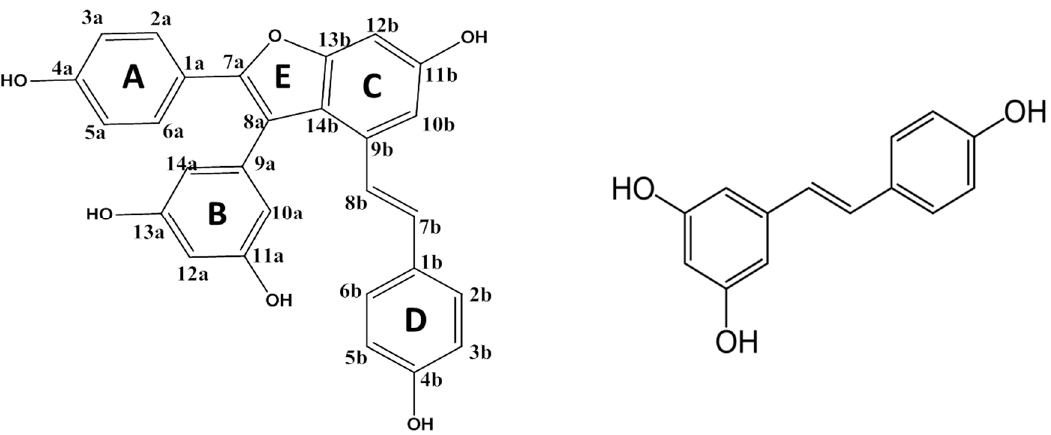
Figure 1. Schematic structures of Vam3 ( left ) and resveratrol ( right ).